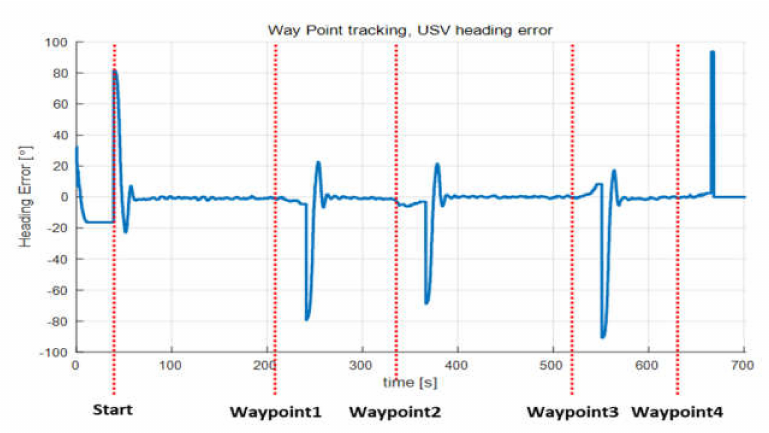
Figure 25. USV heading error during waypoint tracking.